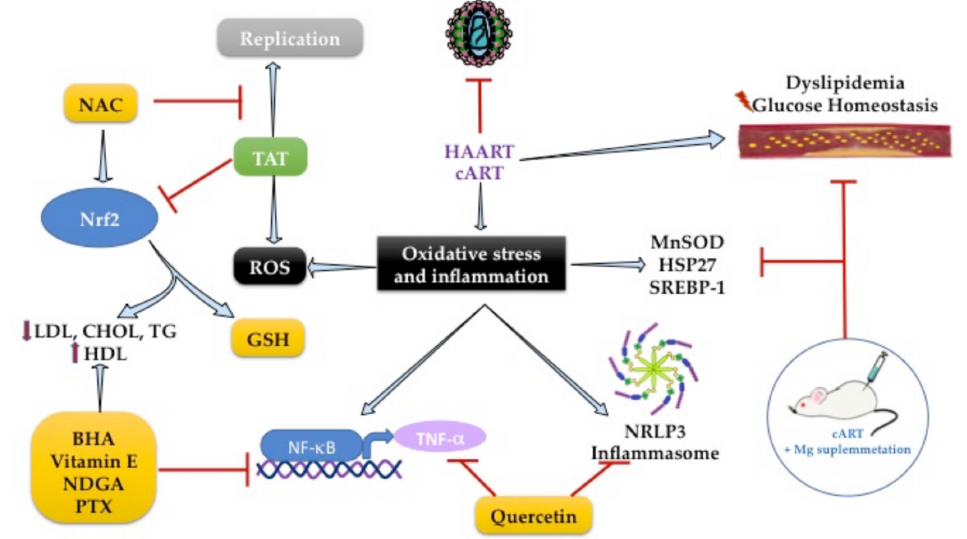
Figure 3. Gene targets antioxidants with antilipidemic effects to reduce oxidative stress and inflam- mation in HIV